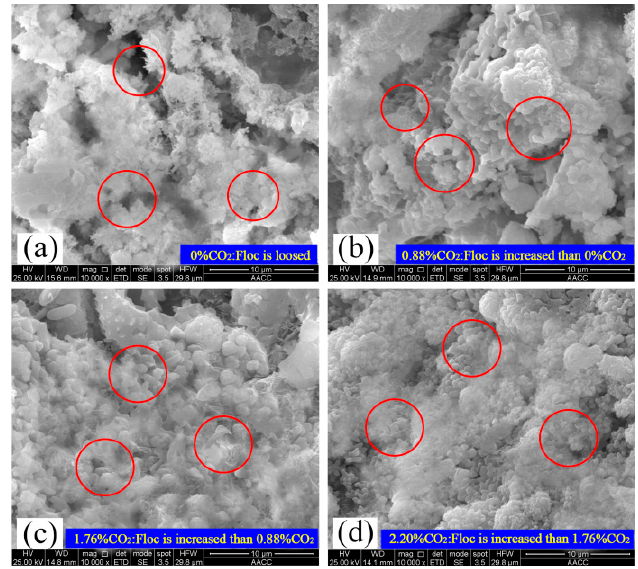
Figure 12. SEM image of carbonized cement by ultrasonic vibration agitation: ( a ) 0%; ( b ) 0.88%; ( c ) 1.76%; ( d ) 2.20%.